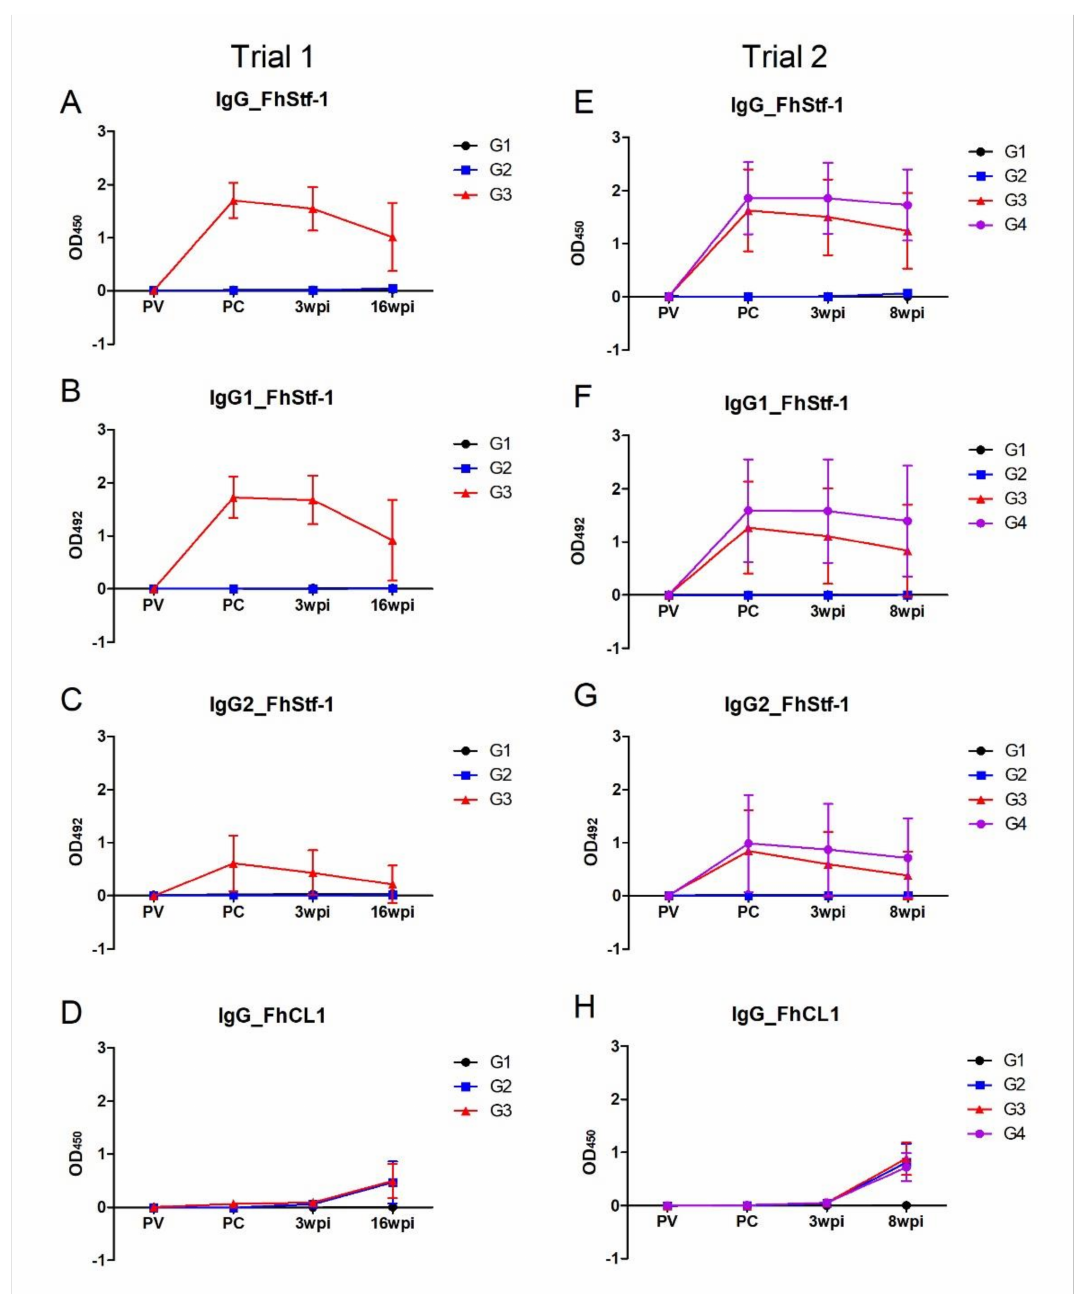
Figure 6. Analysis of antibody responses to F. hepatica recombinant stefin 1 (rFhStf-1). Mean optical density (OD) values are graphically represented for total IgG antibodies ( A and E ), IgG1 antibody subclass ( B and F ) and IgG2 antibody subclass ( C and G ) to rFhStf-1 at four time-points during the vaccine Trial 1 and Trial 2. Antibody responses to F. hepatica infection are displayed as mean OD values for total IgG antibodies to the recombinant cathepsin L peptidase (rFhCL1; D and H ). PV, pre-vaccination, 0 wpi; PC, post-vaccination/pre-challenge with F. hepatica metacercariae. Data represented at ± standard deviation. G1, control unvaccinated, uninfected; G2, control unvaccinated, infected; G3 and G4, vaccinated,